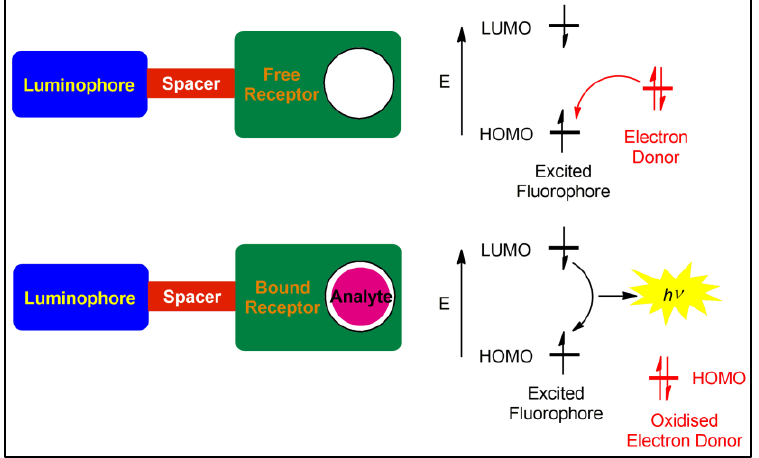
Figure 22. PET mechanism.